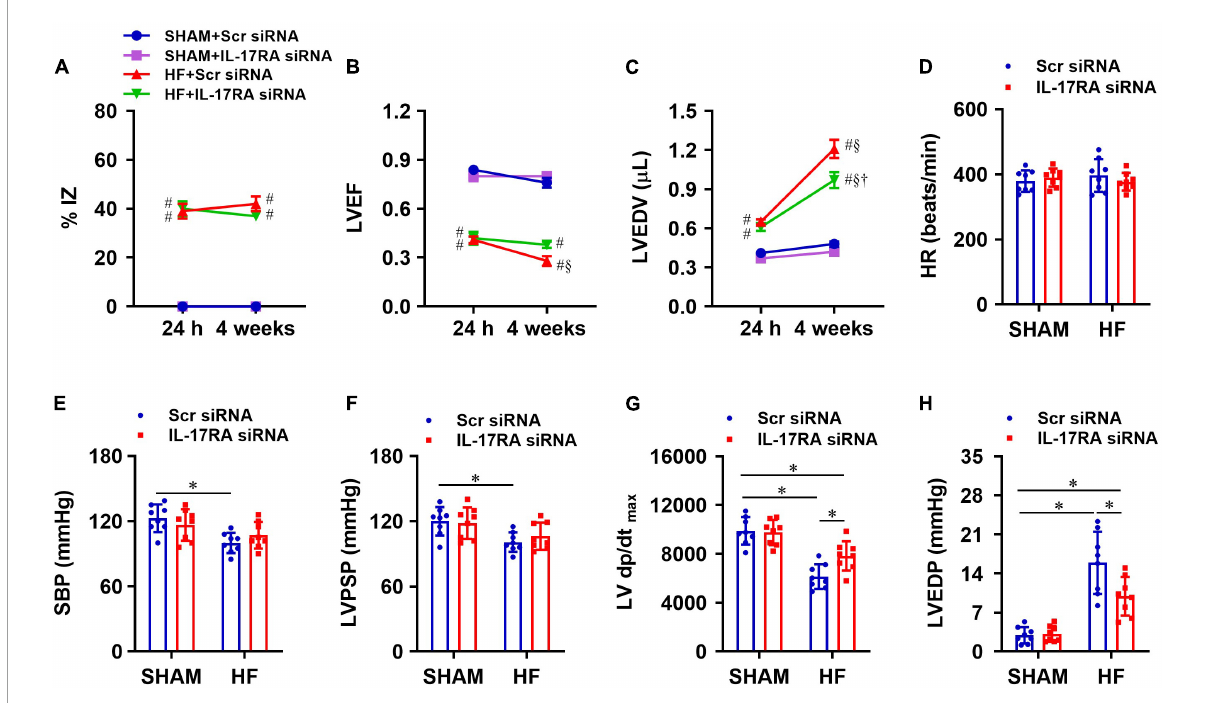
FIGURE6 Quantitative comparison of echocardiographic variables including ischemic zone as a percent of left ventricular (LV) circumference (%IZ, A ), LV ejection fraction (LVEF, B ) and LV end-diastolic volume (LVEDV, C ) 24 h and 4 weeks after coronary artery ligation. (D–H) : quantitative comparison of LV hemodynamic variables including heart rate (HR, D ), systolic blood pressure (SBP, E ), LV peak systolic pressure (LVPSP, F ), maximum rate of rise of LV pressure (LV dP/dt max , G ) and LV end-diastolic pressure (LVEDP, H ) from each group 4 weeks after coronary artery ligation. Values are mean ± SEM ( n = 8 for each group); # p < 0.05 vs. SHAM + Scr siRNA; § p < 0.05 vs. same group at 24 h; † p < 0.05, HF + IL-17RA siRNA vs. HF + Scr siRNA; * p <